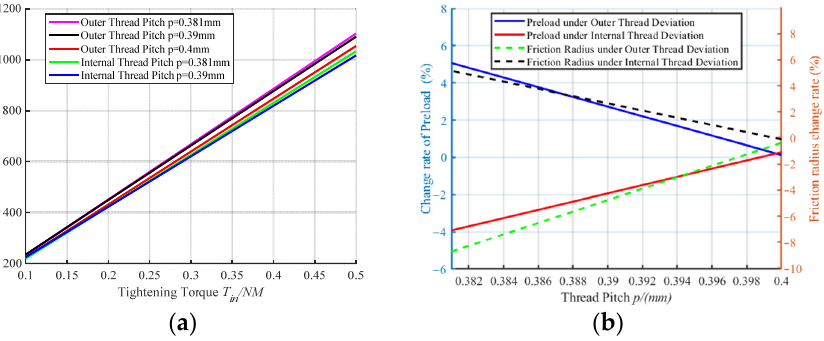
Figure 4. ( a ) Tightening curve under pitch deviation, ( b ) change curve of equivalent friction radius.